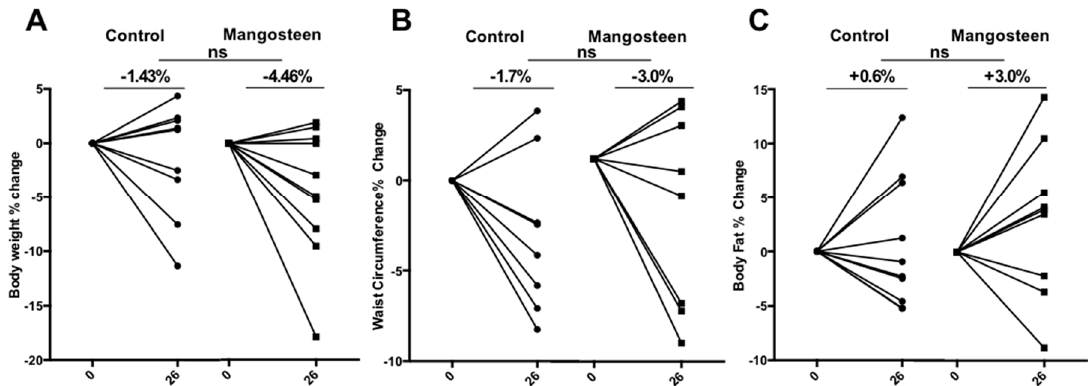
Figure 2. Anthropometric parameters: ( A ) the mangosteen arm experienced weight loss ( − 4.5 ± 6.2%, p = 0.048) that the control failed to do, however groupwise comparison was not significant; ( B ) no statistically significant difference was seen regarding waist circumference in any of the groups; ( C ) no statistically significant difference was seen regarding body fat percentage in any of the groups.